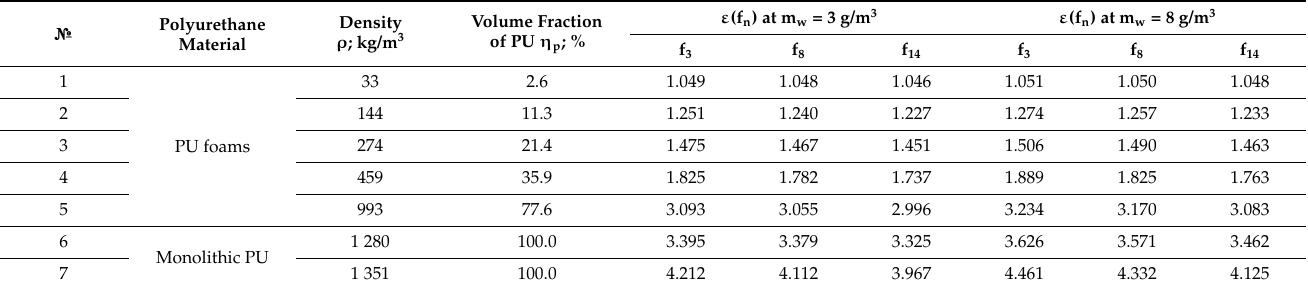
Table 5. The characteristics of polyurethane